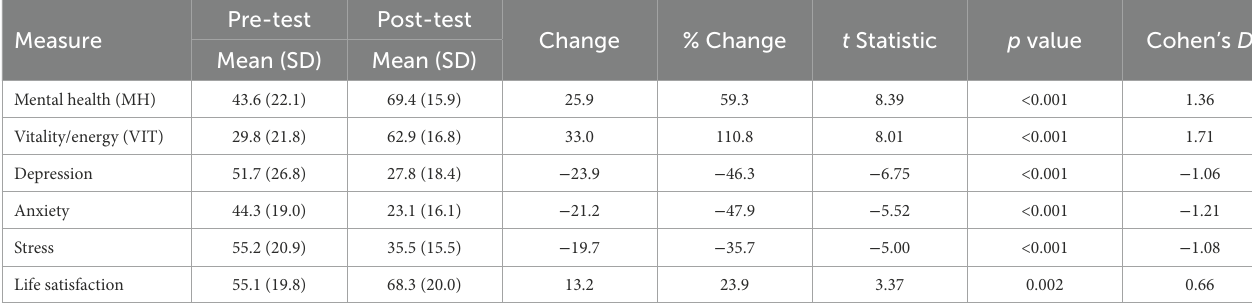
TABLE 2 Changes in the outcome measures from baseline to